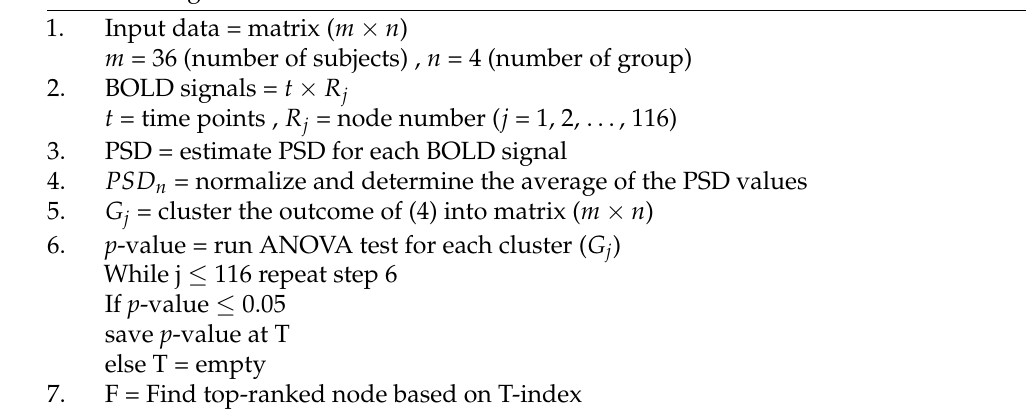
Algorithm 1 Method of finding the top-ranked node in discriminating 3-level ASD subtypes and NC using mean value of